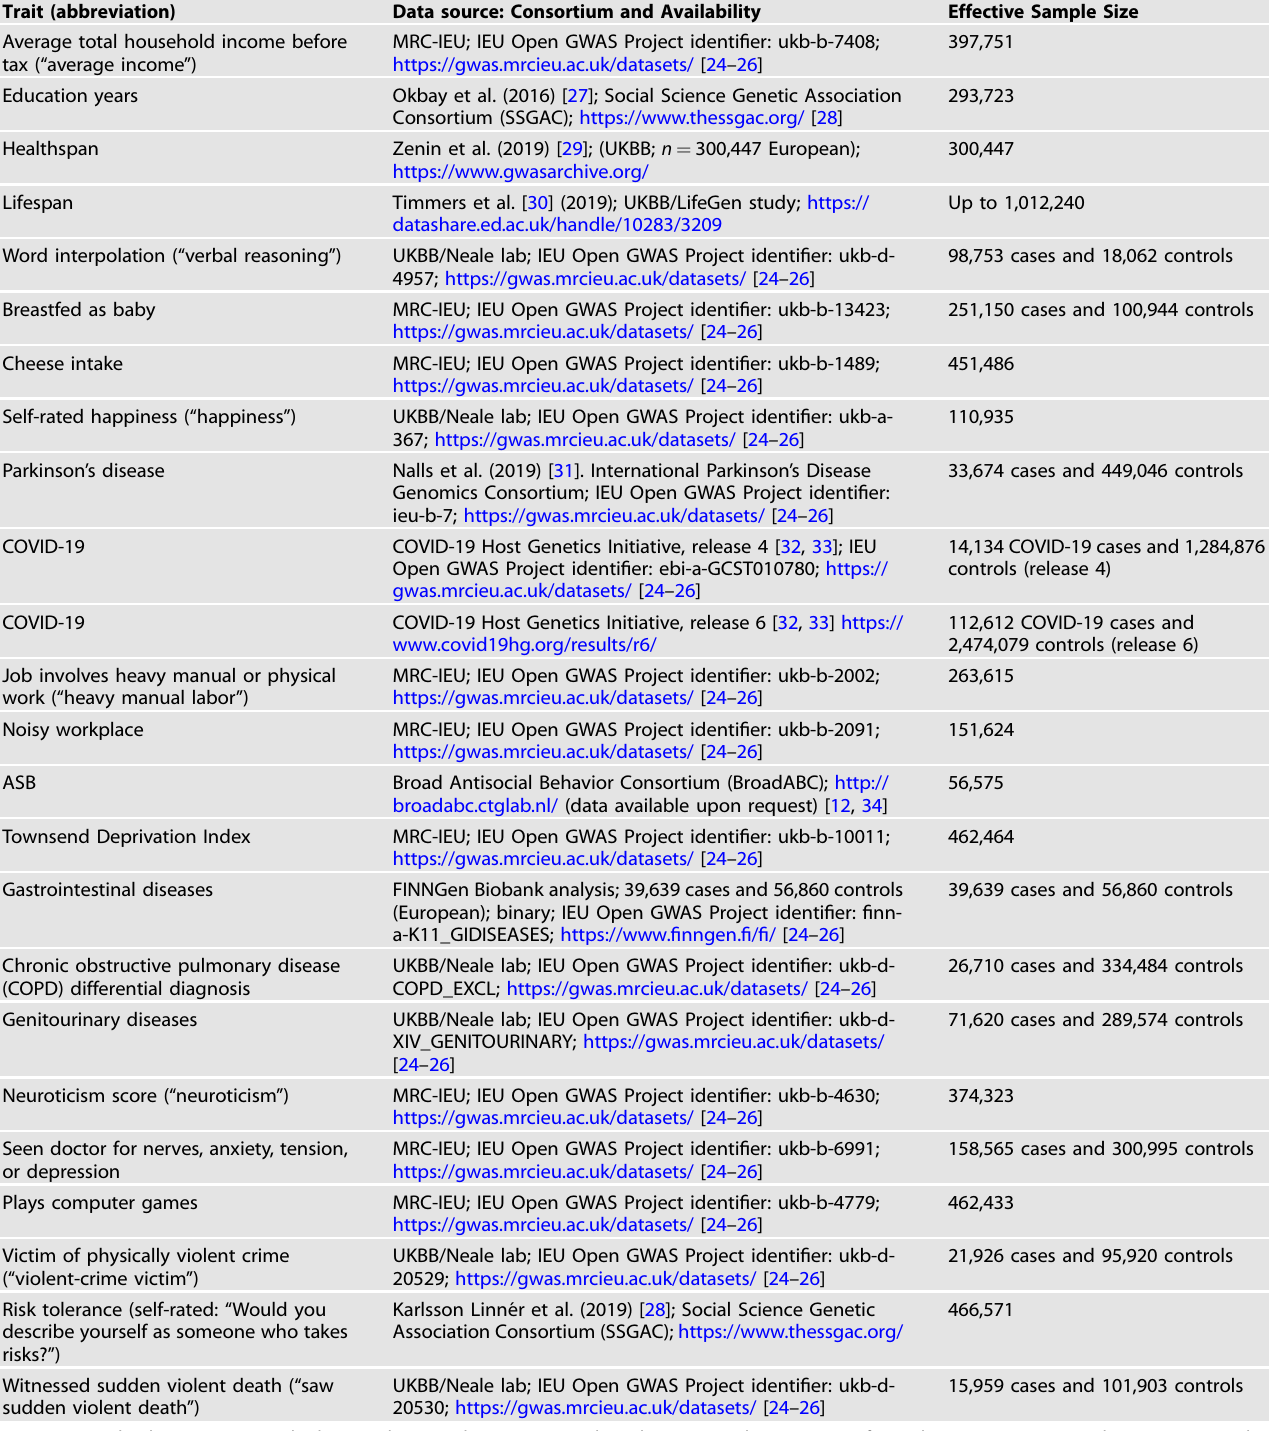
Table 1. GWA study data